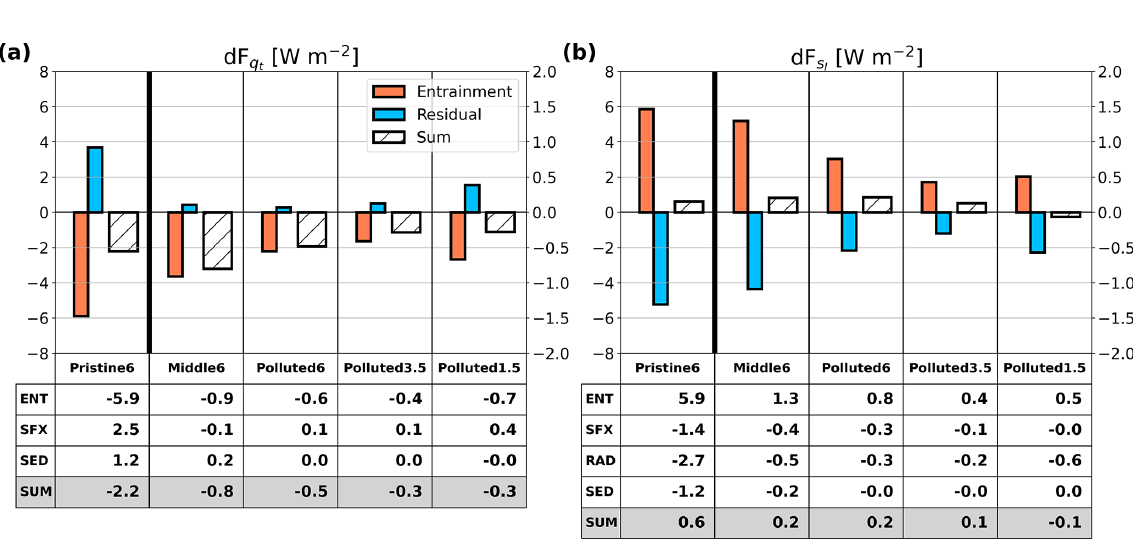
Figure 6. Run-averaged fractional changes between the Plume and Ctrl runs of d w e (hatching), d A (orange), and B (blue) and (cid:49)b (dark green) in the Pristine6, Middle6, Polluted6, Polluted3.5, and Polluted1.5 cases. Note that the y -axis scale for the Pristine6 case (left-hand side of plot) is 10 times greater than that for the other cases (right-hand side of plot). The table below the histograms shows the values of the fractional changes and the residual between fractional change in d w e as well as the sum of the rest of the values.